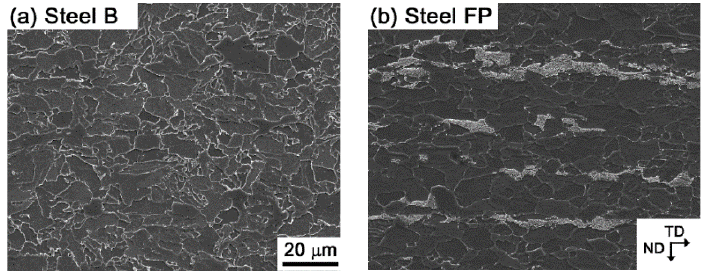
Figure 3. Field emission scanning electron microscope (FE-SEM) images of the two steels from transverse cross-sections (TC): ( a ) steel B, ( b ) steel FP. Both images were obtained from position 3 of the mid-thickness region.